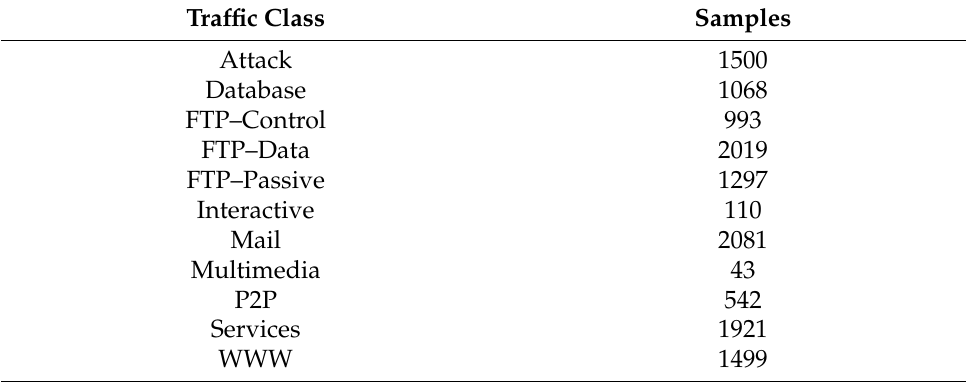
Table 2. Characteristics of the traffic classification dataset used in this